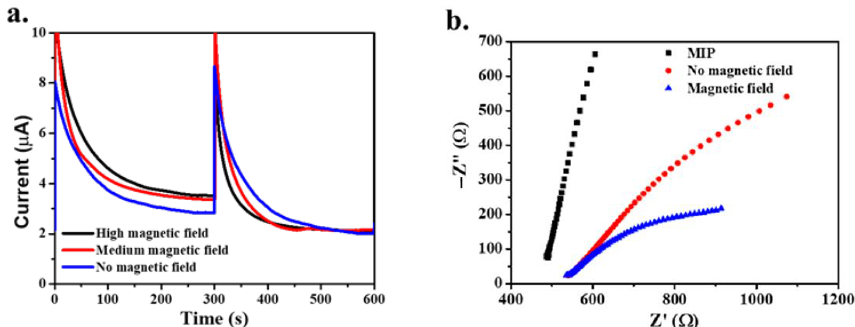
Figure 4. Effect of the applied external magnetic field’s force on current ( a ) and resistance ( b ).